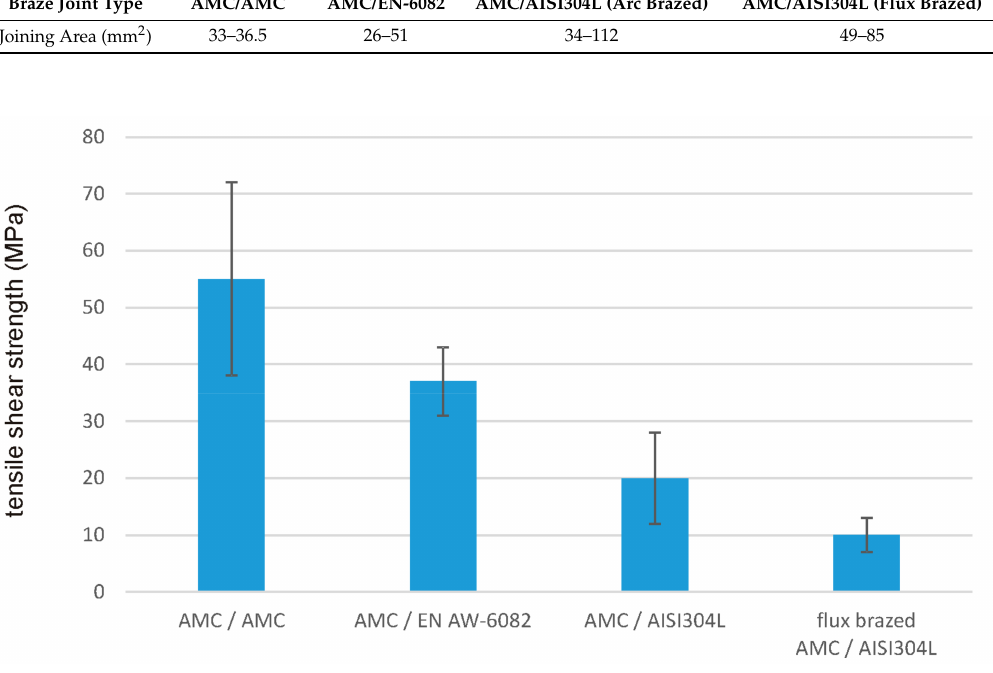
Figure 7. Bond strength values resulting from tensile shear tests for different similar and dissimilar braze joints using arc brazing routine and braze filler